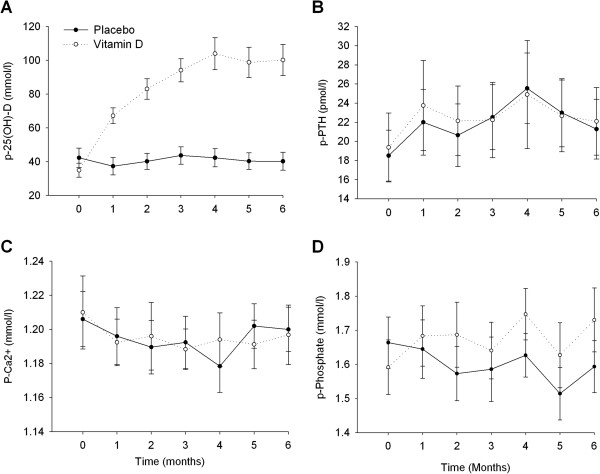
Mean plasma concentrations of 25-hydroxy-vitamin D (p-25(OH)-D) (A), p-PTH (B), plasma ionised calcium (p-Ca
2+
) (C) and p-phosphate (D) with SEM (n = 50).